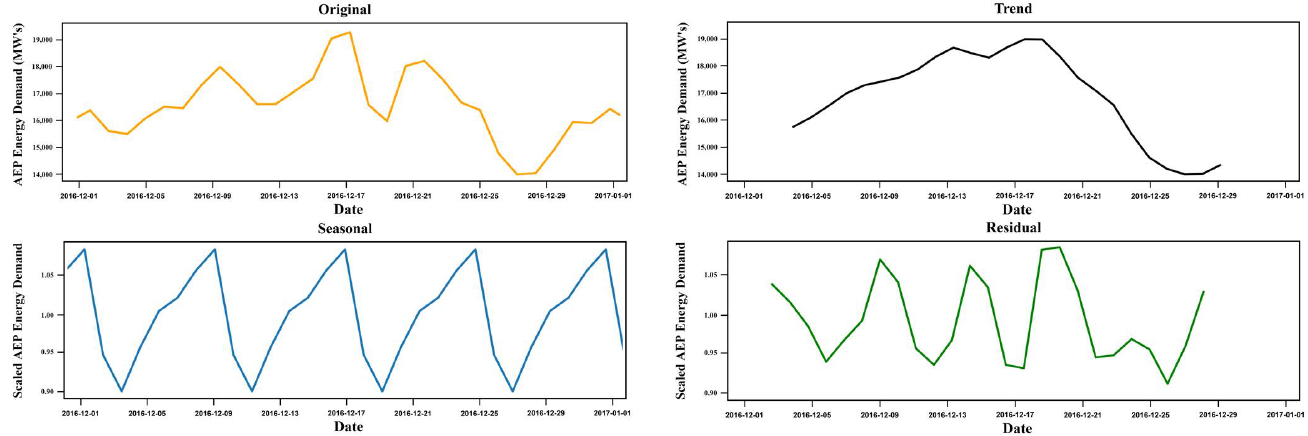
Figure 6. A.E.P. original and decomposed data for December